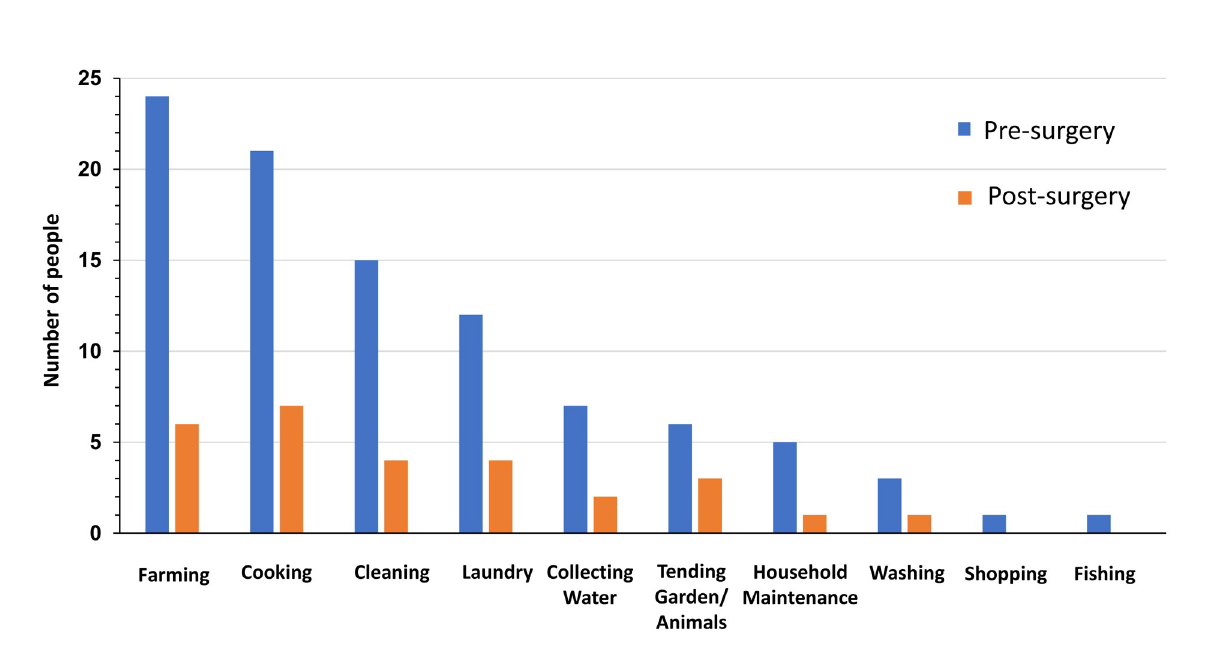
Fig 1. The types of activities caregivers assisted the patient with pre- and